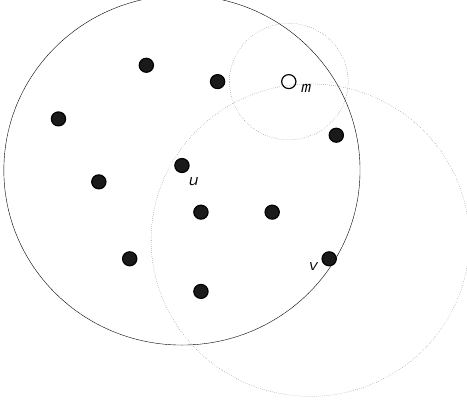
Figure 2. Definition of communication range and neighbor.